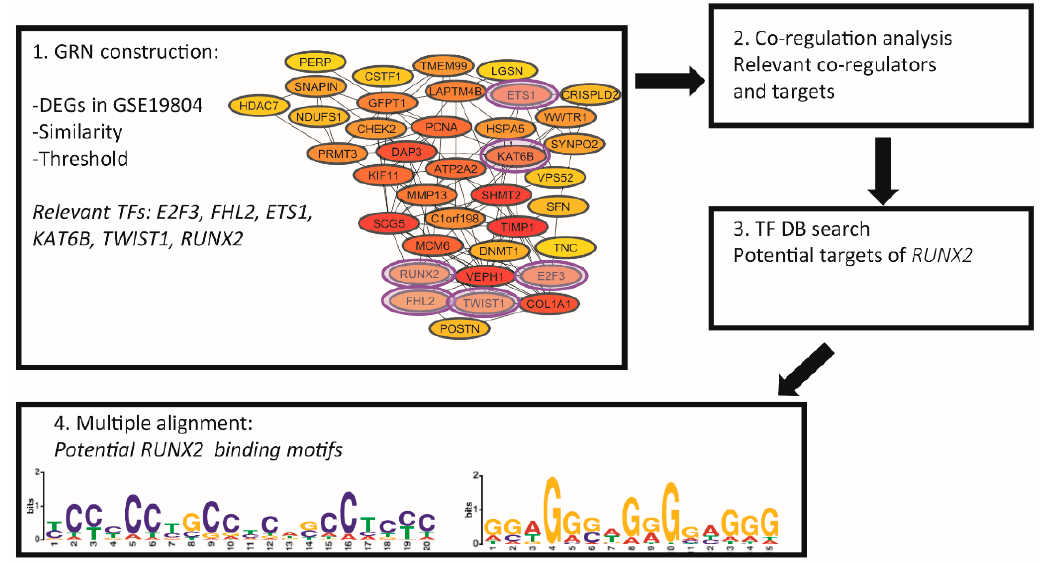
Figure 1. Bioinformatics pipeline used in this work and results in every step: 1. Gene regulatory network (GRN) construction using an in-house methodology. 2. Coregulatory analysis of the main transcription factors (TFs) identified in step 1. 3. Database (DB) search of the reported targets of the most relevant TF (RUNX2) identified in step 2. 4. Identification of potential binding motifs of RUNX2 based on the targets.